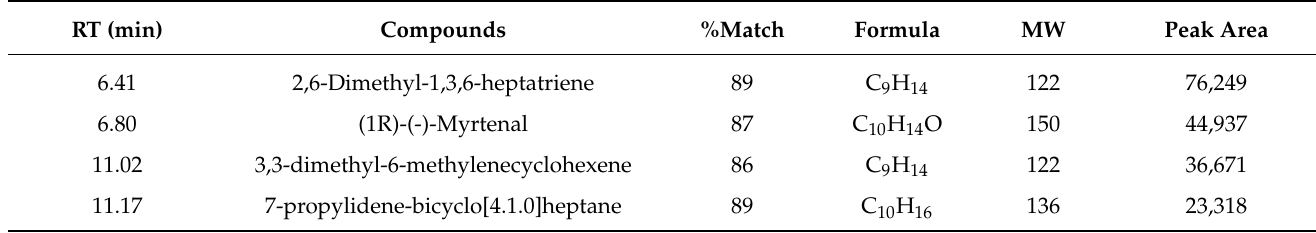
Table 1. Volatile compounds produced by Streptomyces sp. Z1-04-02, identified through GC/MS analysis.